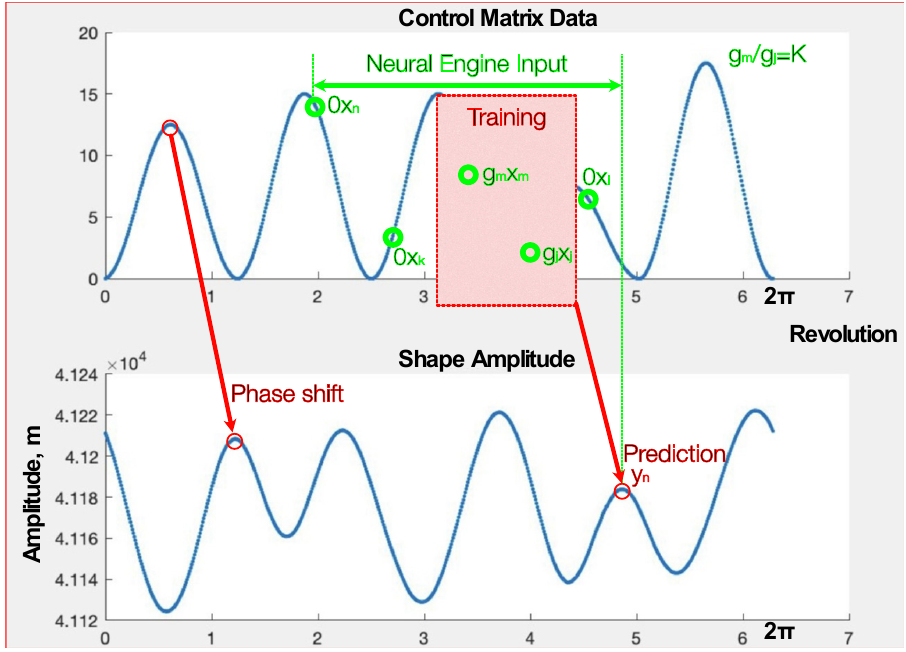
Figure 9. The use of values or segments of the previous system states for predictive control during insufficient feedback speed or control failure.